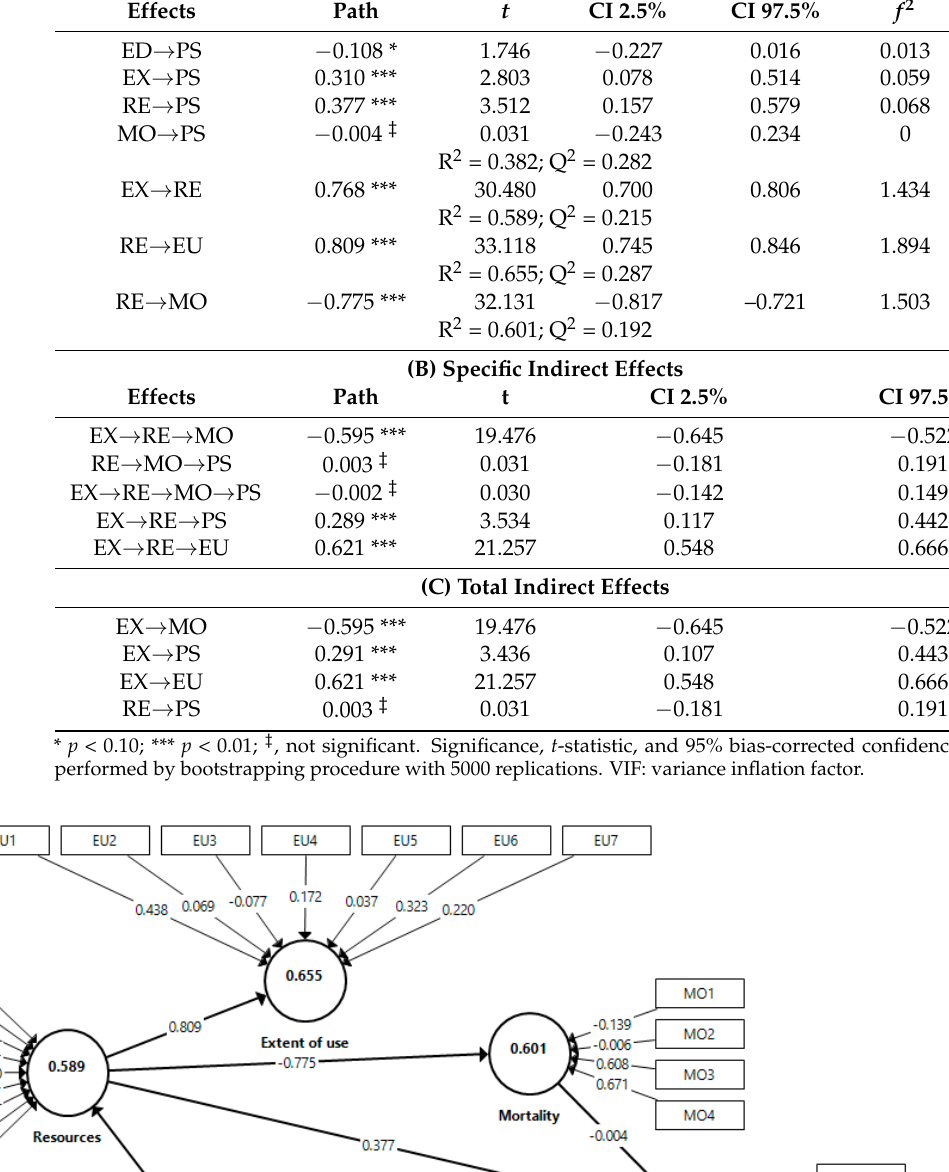
Table 7. Assessment of the structural model for women.